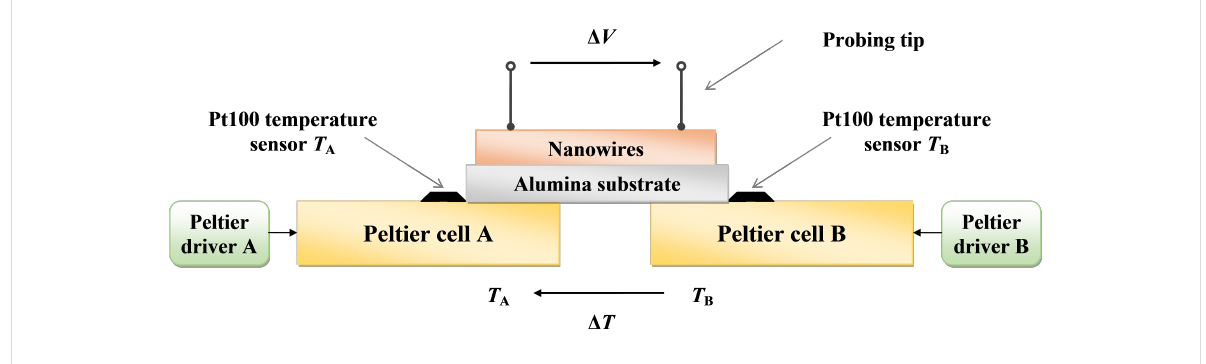
Figure 8: Schematic diagram (side view) of the experimental set-up for the measurement of the thermoelectric response of nanowires-based samples (not to scale).